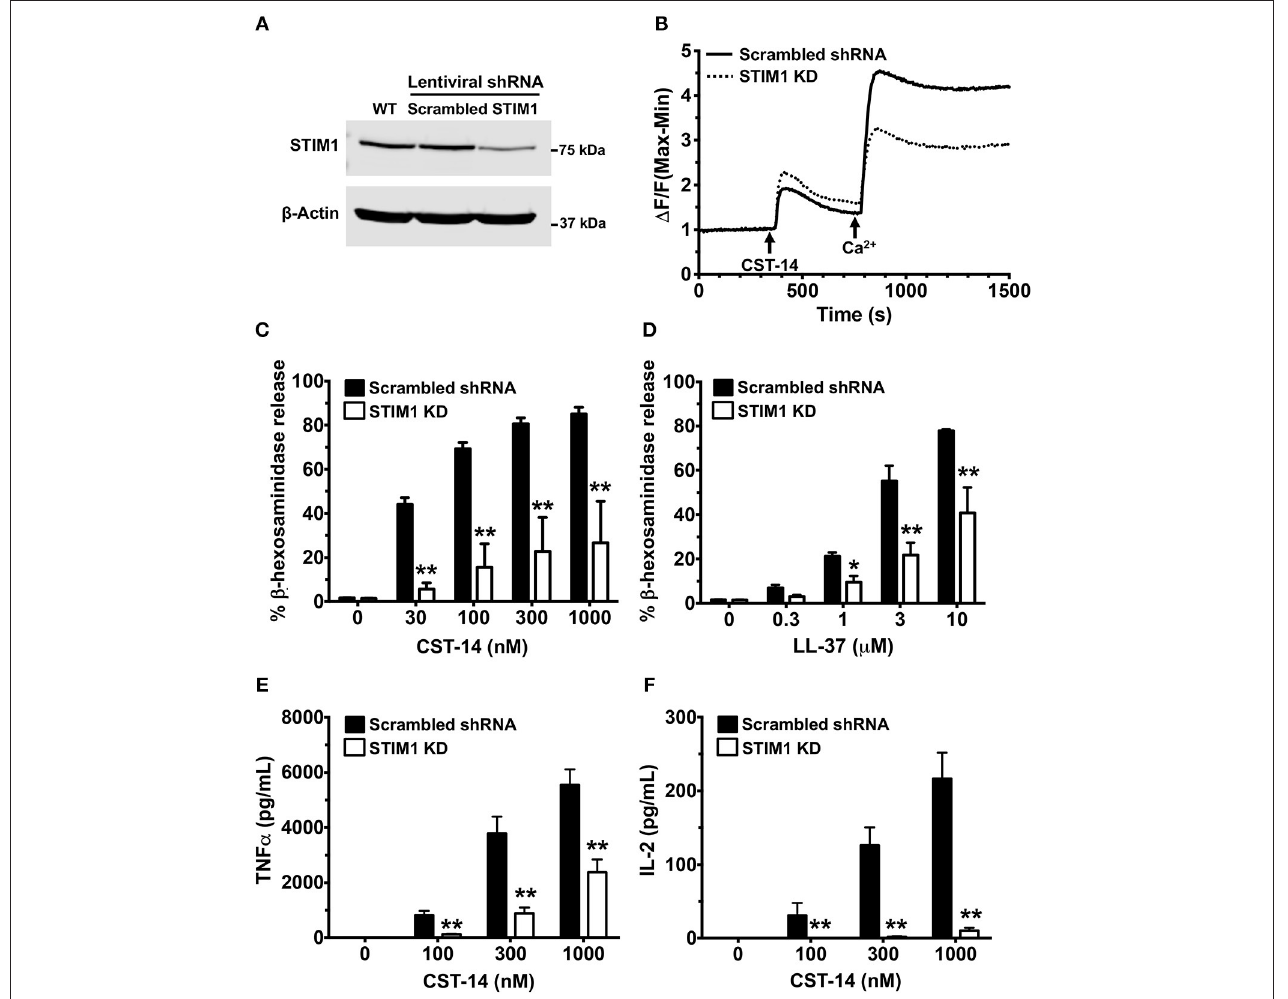
FIGURE 6 | Silencing STIM1 expression inhibits Ca 2 + mobilization, degranulation and cytokine production in LAD2 mast cells. LAD2 cells were stably transduced with lentivirus containing STIM1 or scrambled shRNA (control). (A) A representative blot of STIM1 levels in wild type (WT), scrambled and STIM1 shRNA-transduced cells is shown. (B) Control and STIM1 knockdown (KD) cells were labeled with the Calcium 6 dye in Ca 2 + -free buffer. Traces represent the changes in fluorescence following the addition of CST-14 (300nM) and 2mM Ca 2 + . (C,D) Cells were stimulated with indicated concentrations of CST-14 or LL-37 and β -hexosaminidase release was determined. (E,F) Cells were treated with CST-14 for 6h, and ELISA was performed to estimate TNF- α and IL-2 levels in the supernatants. Data is mean ± S.E. from three experiments. Statistical significance was determined by two-way ANOVA. * p < 0.05 and ** p <